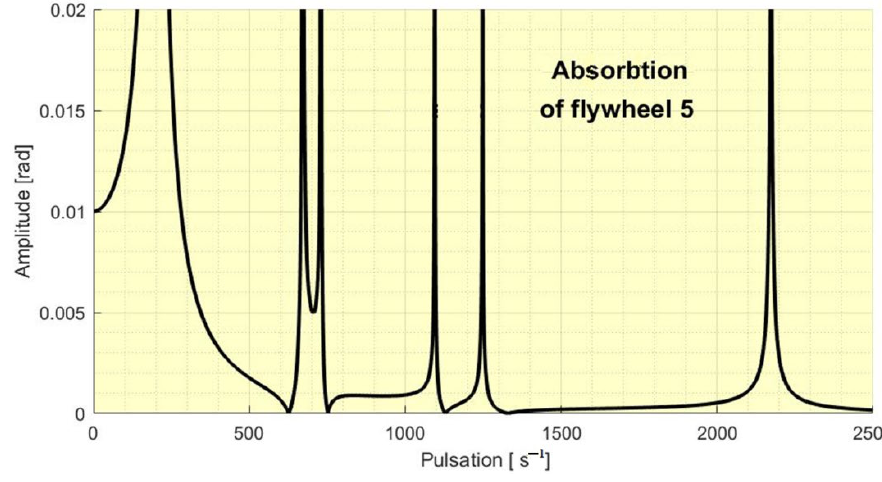
Figure 4. The absorbtion of the flywheel 5.